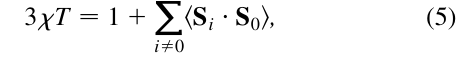
FIG. 4. Solid lines: 3 (cid:4)T for spins, from Eq. (1), and 3 (cid:4) pseudospins, as in Fig. 3. Blue triangles: Bulk magnetometry measurements of a single crystal of Ho